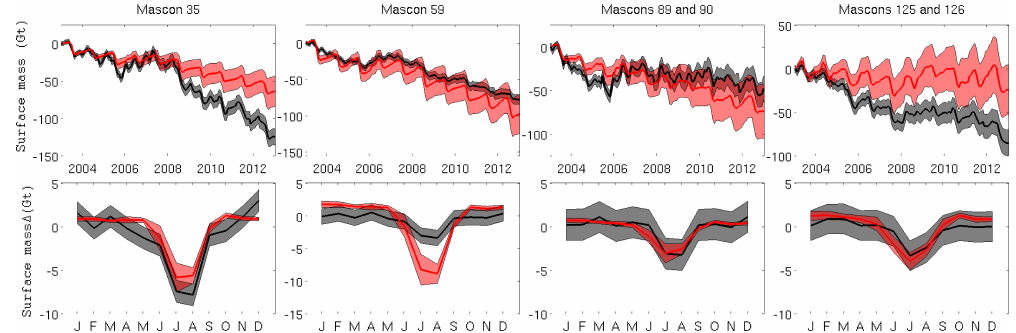
Figure 9. Same as Fig. 8 but for Northeast